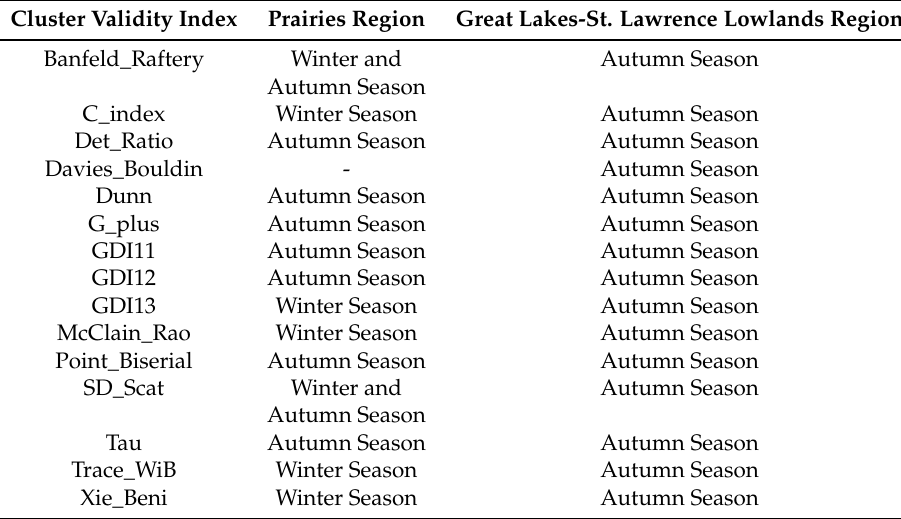
Table 2. Season-wise comparison of cluster validity